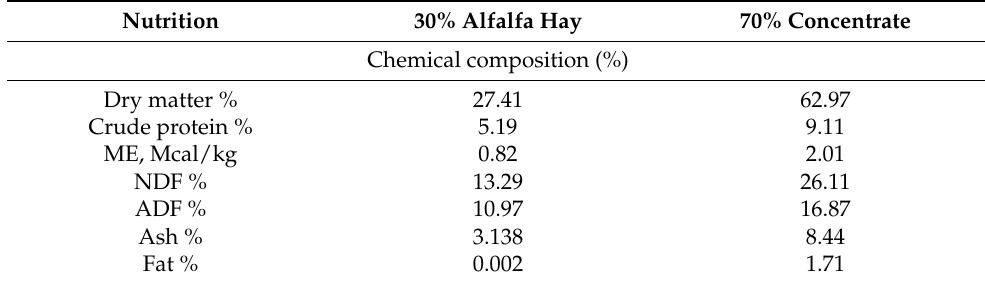
Table 1. The chemical composition and fatty acid profile of the traditional forage (alfalfa hay) and concentrate based on dry